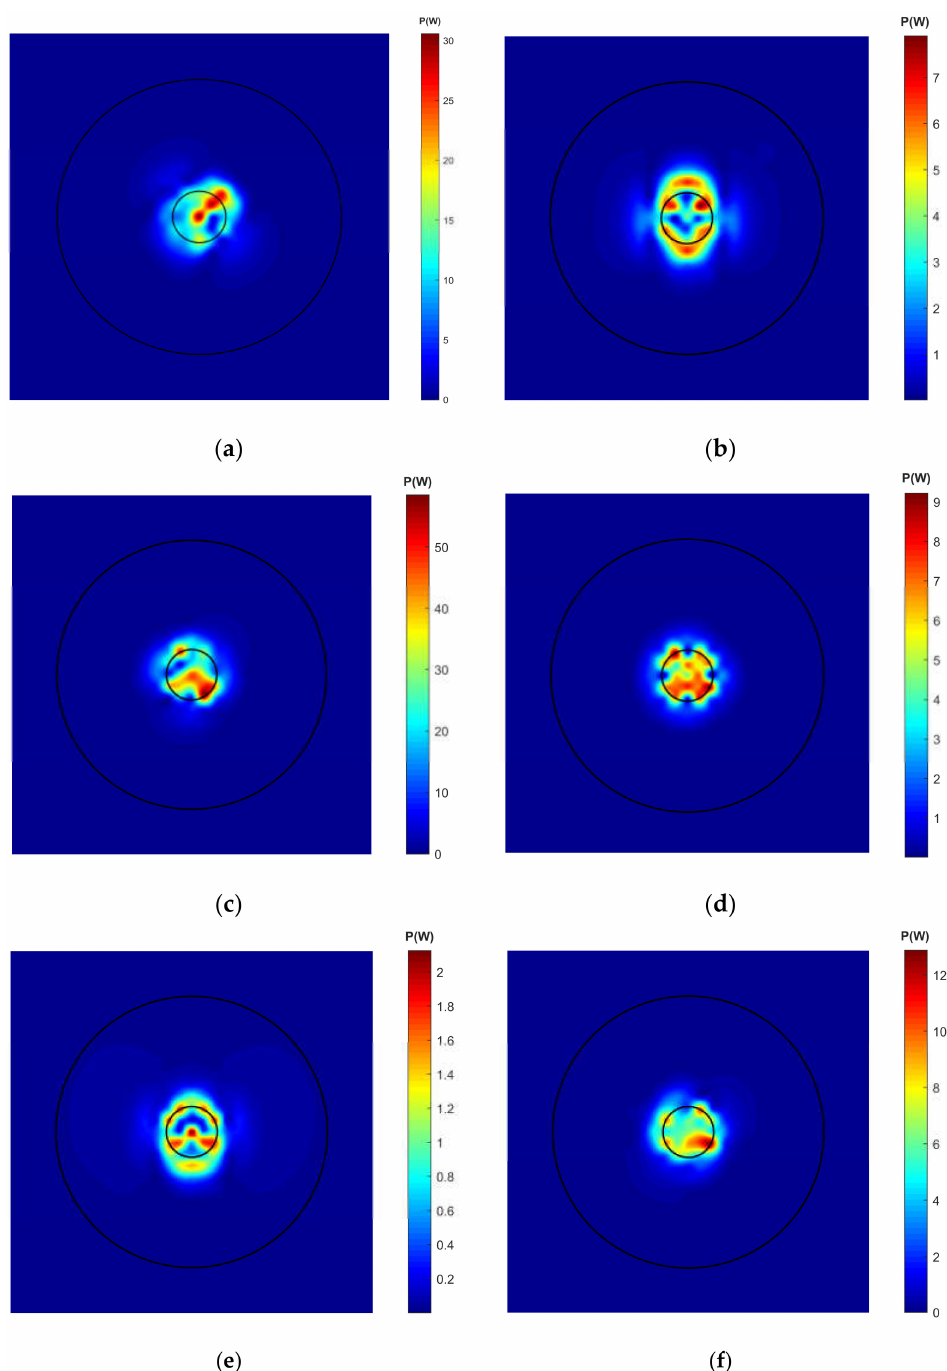
Figure A4. Structural intensity contours at an excitation frequency of 1000 Hz: ( a ) ABH(i) with BC 1, ( b ) ABH(ii) with BC 1, ( c ) ABH(iii) with BC 1, ( d ) ABH(i) with BC 2, ( e ) ABH(ii) with BC 2, ( f ) ABH(iii) with BC